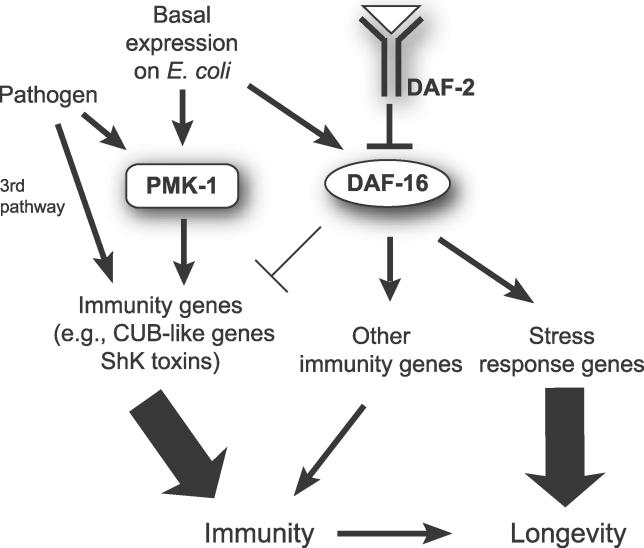
A Model for Regulation of Immunity/Longevity by the PMK-1 p38 MAPK Pathway and the DAF-2–DAF-16 Insulin-Signaling Pathway in C. elegans
We propose that the PMK-1 p38 MAPK pathway plays an active role in response to bacterial pathogens. PMK-1 controls basal levels of pathogen response genes on E. coli and also mediates induction of these genes upon infection. In contrast, DAF-16 controls a separate group of immune genes and does not mediate the infection response, but does turn down expression of some pathogen-induced genes. Certain pathogen response genes are induced independently of PMK-1 or DAF-16, indicating the existence of a third pathway. PMK-1 is required for the enhanced pathogen resistance of daf-2 mutants because it is the predominant pathway contributing to immunity. Finally, we suggest that PMK-1 contributes to enhanced longevity of daf-2 mutants because intact immune function promotes longevity.